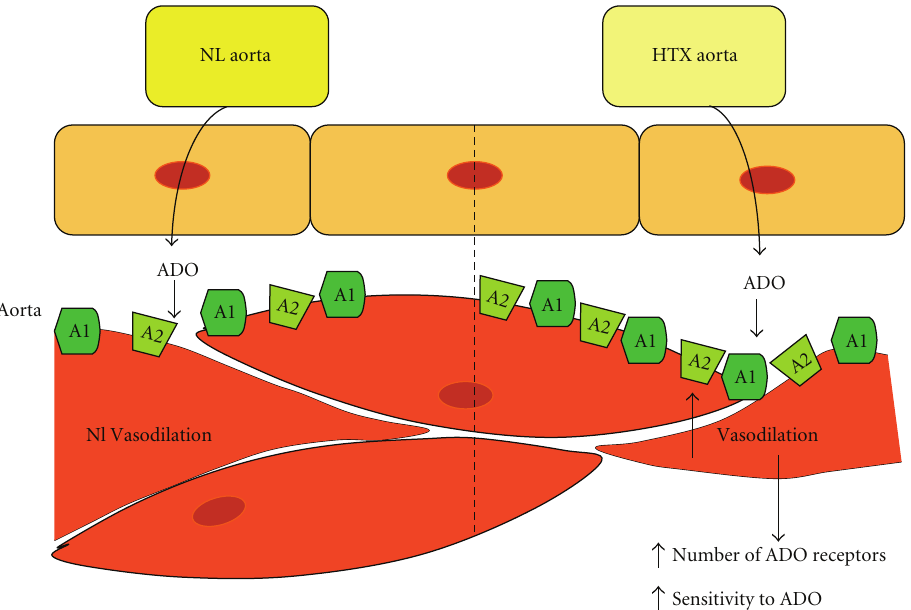
Figure 7: In spite of a similar norepinephrine-induced vasoconstriction of the aortic rings from normal (NL) and hypothyroid (HTX) rats, adenosine- (ADO-) induced vasodilation is markedly higher in the HTX aortic rings. Increased number of adenosine receptors or a higher sensitivity to the receptors to exogenous adenosine may explain the higher sensitivity of HTX aortic rings to ADO.